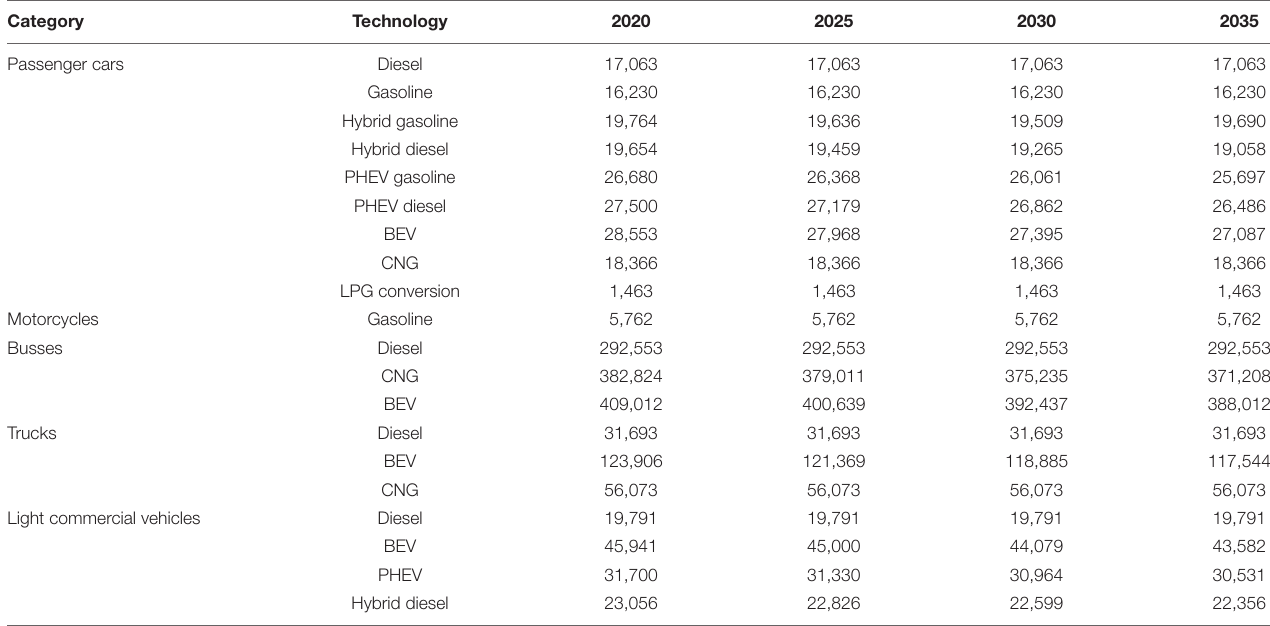
TABLE A2 | Vehicle purchase cost